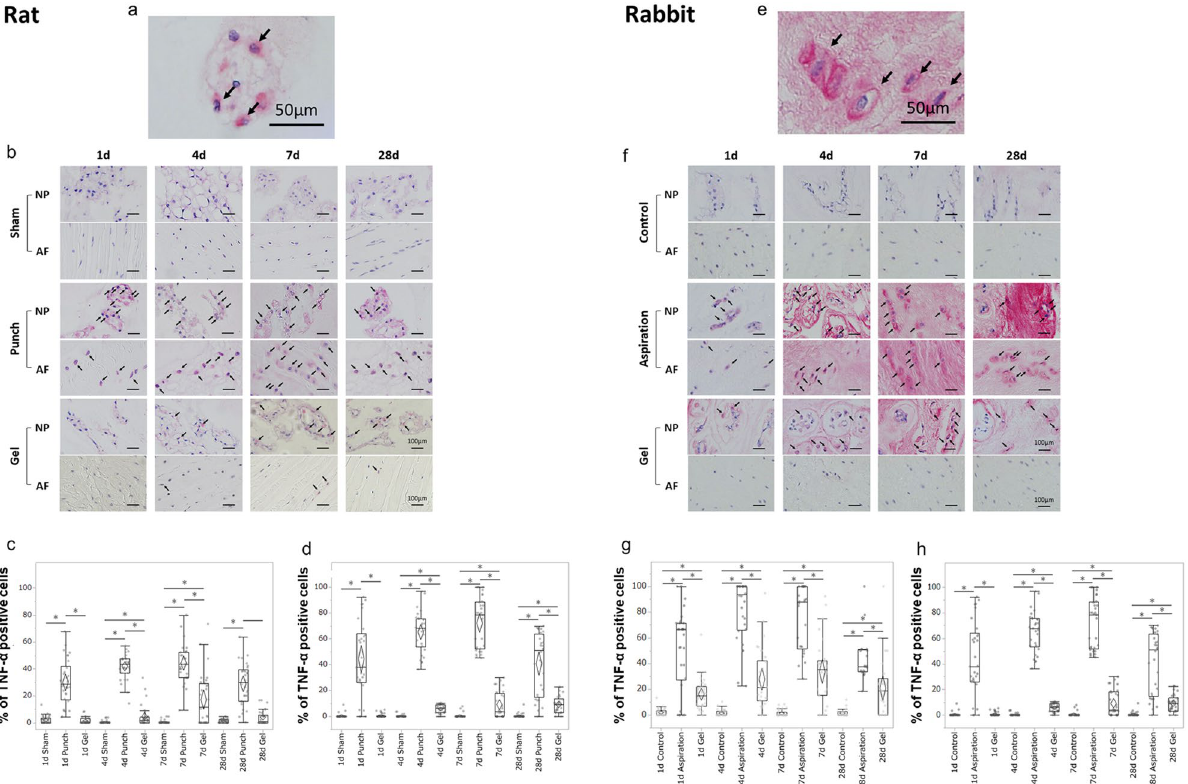
Figure 2. UPAL gel inhibits tumour necrosis factor alpha (TNF-α) production in rat and rabbit intervertebral disc (IVD) degeneration models. The rat nucleus pulposus (NP) punch ( a – d ) and rabbit NP aspiration ( e – h ) models were used for immunohistochemical (IHC) analysis to detect the TNF-α levels 1, 4, 7, and 28 days after surgery. The number of TNF-α-positive cells in each staining was calculated as a percentage of the number of total NP or annulus fibrosus (AF) cells in five independent, randomly selected fields per disc. TNF-α-positive cells are stained red, and nuclei was stained purple. ( a ) Representative image of TNF-α-positive NP cells in the rat model (allows). Scale bar, 50 µm. ( b ) Representative IHC staining for TNF-α 1, 4, 7, and 28 days after surgery in rat NP and AF tissues. Arrows indicate TNF-α-positive cells. Scale bar, 100 µm. Percentage of TNF-α-positive cells in rat NP tissue ( c ) and AF tissue ( d ). ( e ) Representative image of TNF-α-positive NP cells in the rabbit model (arrows). Scale bar, 50 µm. ( f ) Representative IHC staining for TNF-α 1, 4, 7, and 28 days after surgery in the rabbit NP and AF tissues. Arrows indicate TNF-α-positive cells. Scale bar, 100 µm. Percentage of TNF-α positive cells in rabbit NP tissue ( g ) and AF tissue ( h ). The percentages of TNF-α-positive NP and AF cells in the gel group were significantly lower than those in the punch or aspiration group at each time point in the rat or rabbit model, respectively (* P < 0.05). The boxes represent the median and the interquartile range, with the vertical lines showing the range. The rhombus shape represents the 95% confidence interval (at each time point, n = 3 rats; n = 6 IVDs in each